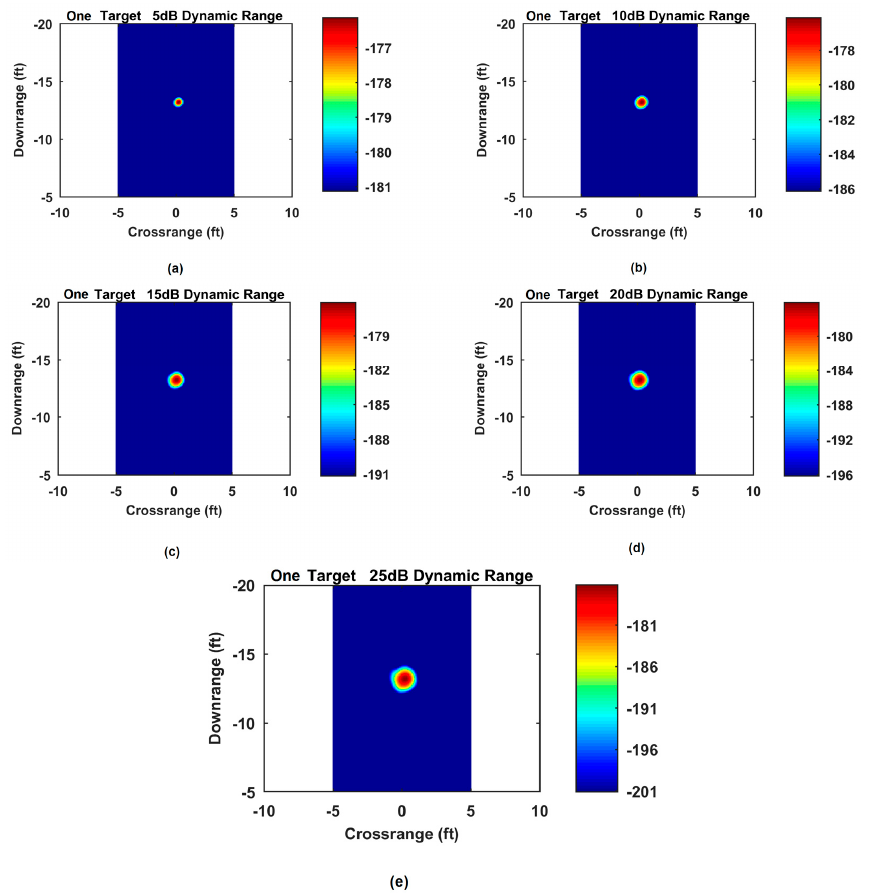
Figure 12. Fused images of a single target over 5–25 dB image dynamic range: ( a ) 5 dB; ( b ) 10 dB; ( c ) 15 dB; ( d ) 20 dB; ( e ) 25 dB.